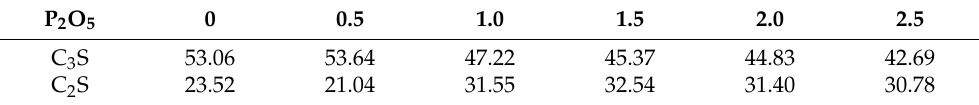
Table 1. Influence of P 2 O 5 on the content of C 3 S and C 2 S in clinkers